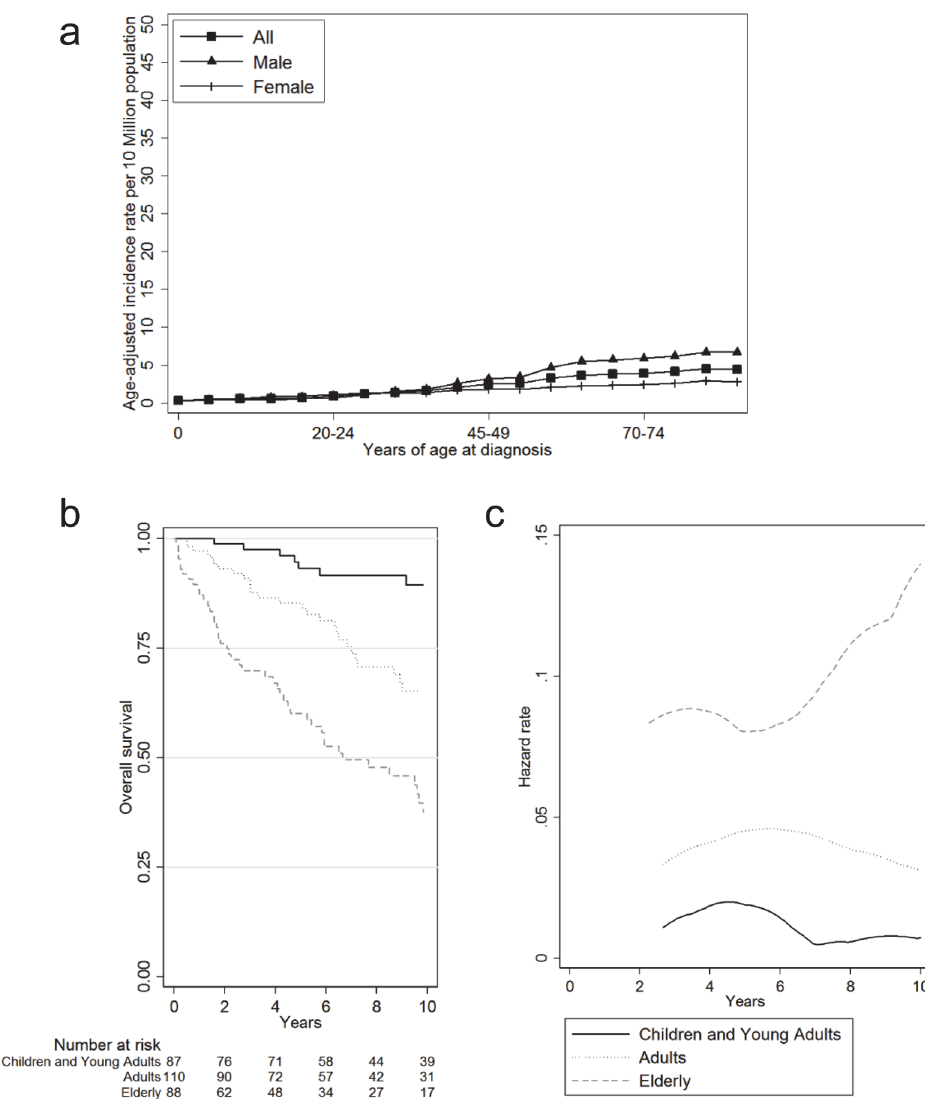
Fig 1. Incidence rate and overall survival. (a) Smoothed incidence rates (per 10 million) across patient ages at diagnosis, by sex. (b) Kaplan-Meier curves and (c) smoothed hazard rates by age group.